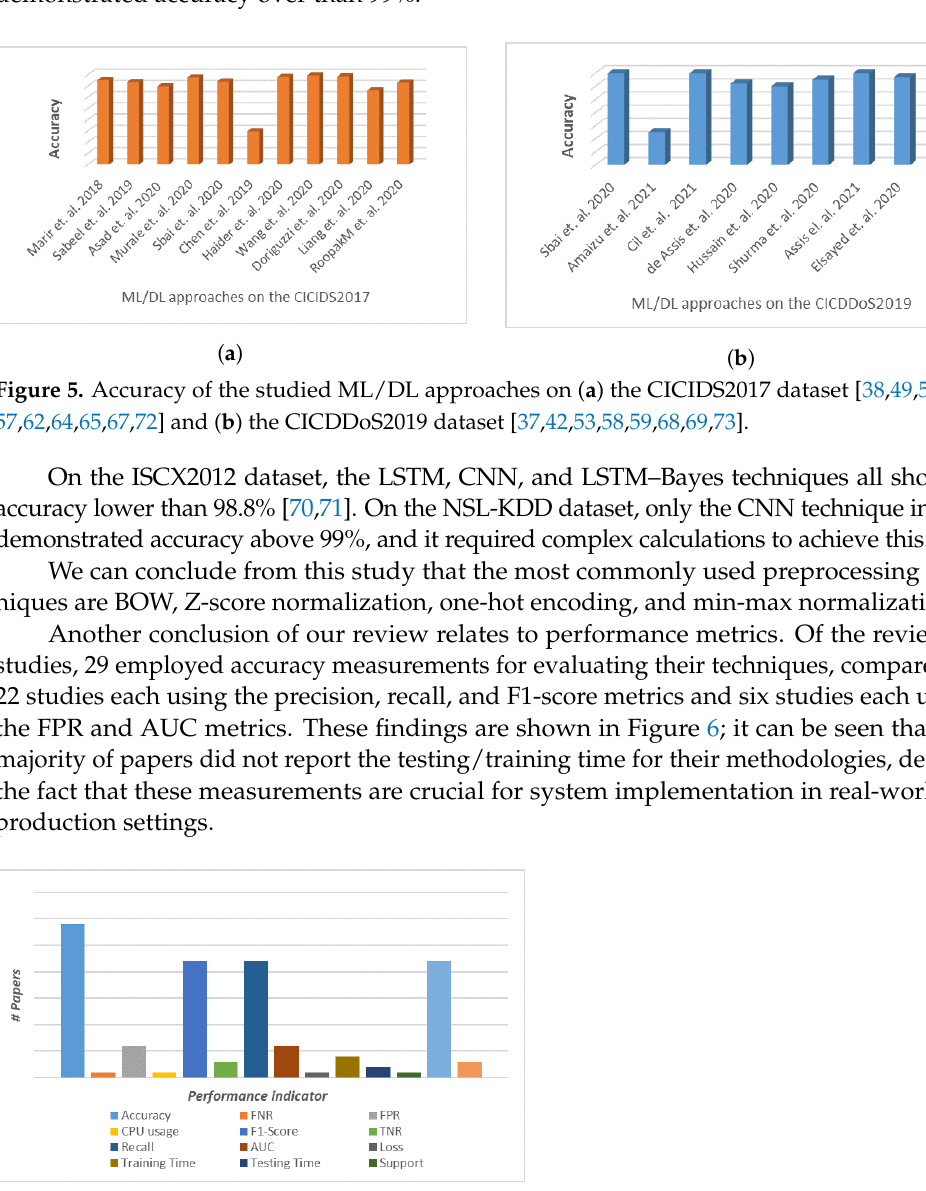
Figure 6. The proportion of ML/DL methods that utilized different performance